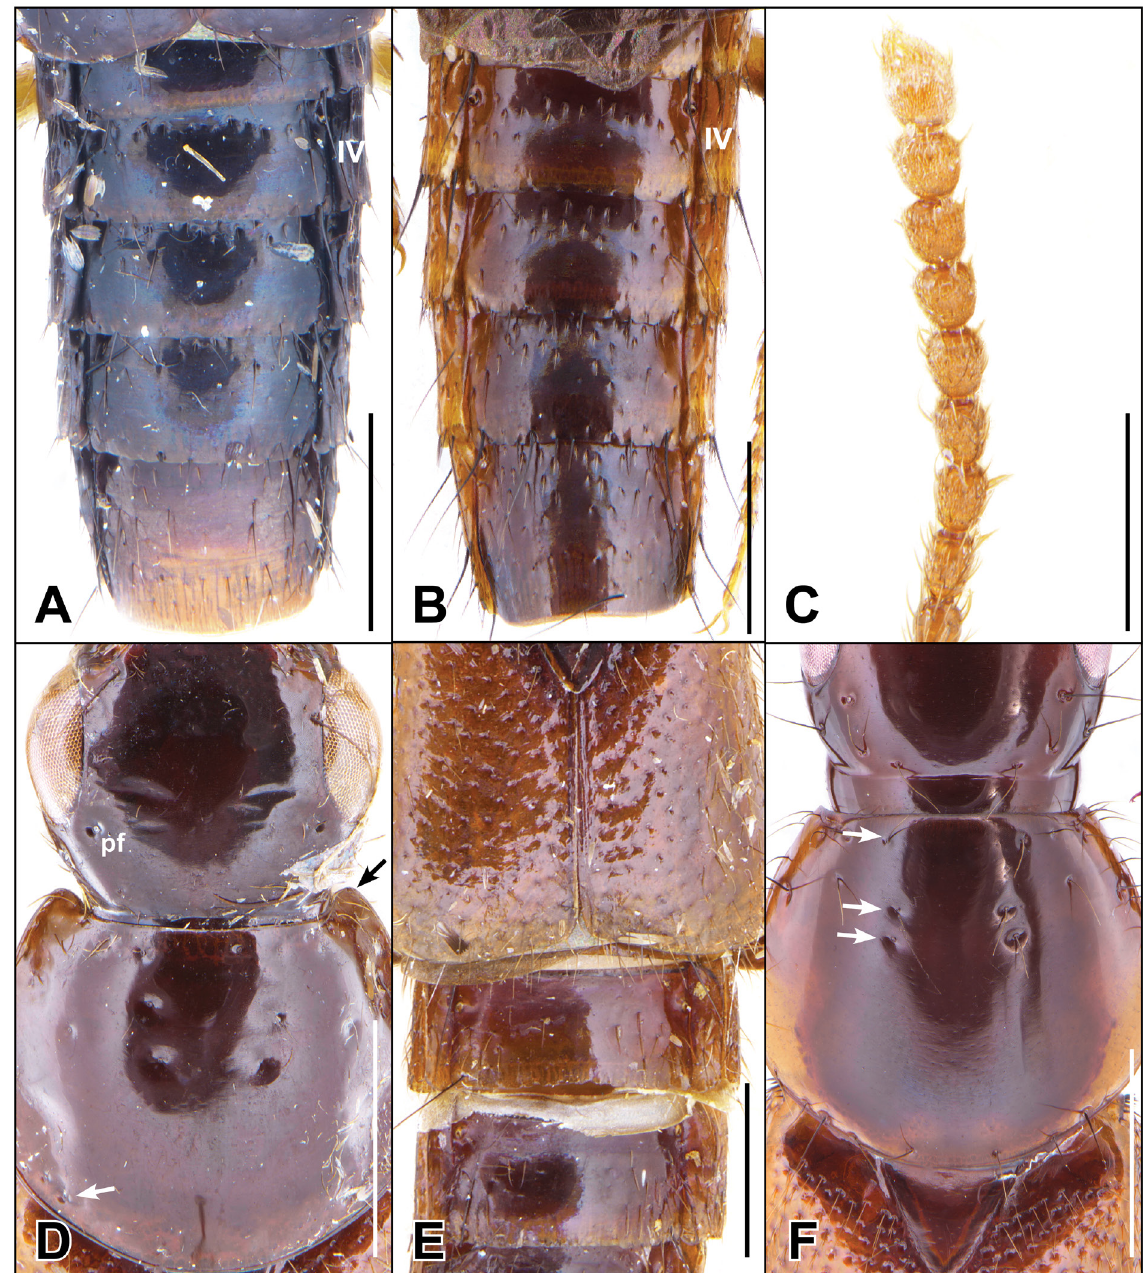
Fig. 5. A . Malaisdius ruficeps (Scheerpeltz, 1965), dorsal abdomen. B . M. smetanai gen. et sp. nov., dorsal abdomen. C–E . Quedius ( Microsaurus ) rutilipennis Scheerpeltz, 1965. C . Antenna. D . Pronotum (white arrow: marginal punctures removed from marginal bead; black arrow: anterior angles with marginal bead entirely visible in dorsal view). E . Elytra and basal abdomen. F . Q. ( M. ) masasatoi Smetana, 2007, pronotum (arrows indicating punctures of the dorsal row). Abbreviation: Pf = posterior frontal puncture. Scale bars: A–B, D–E = 1 mm; C, F = 0.5